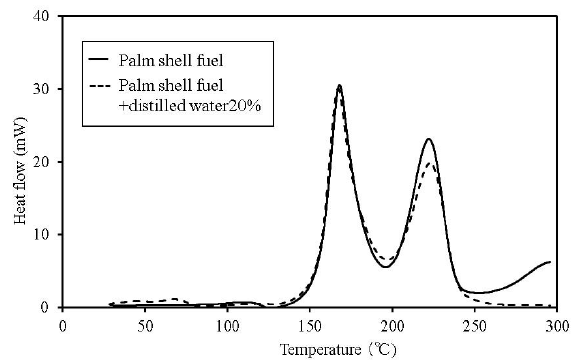
Figure 8. C80 calorimetry curves for palm shell fuel.